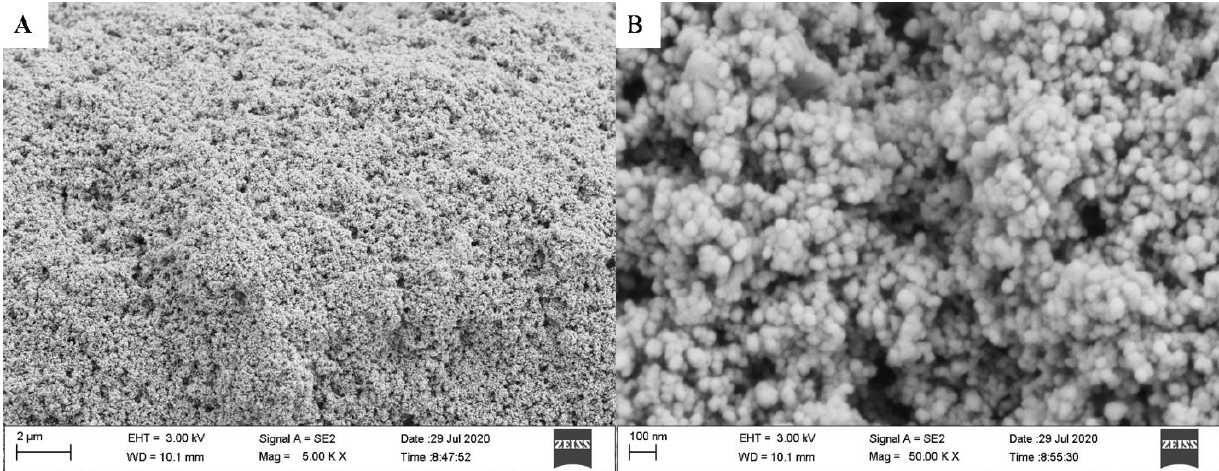
Figure 14. SEM images ( A ) low and ( B ) high magnifications of TiO 2 thin film coated on the Pyrex glass substrate.